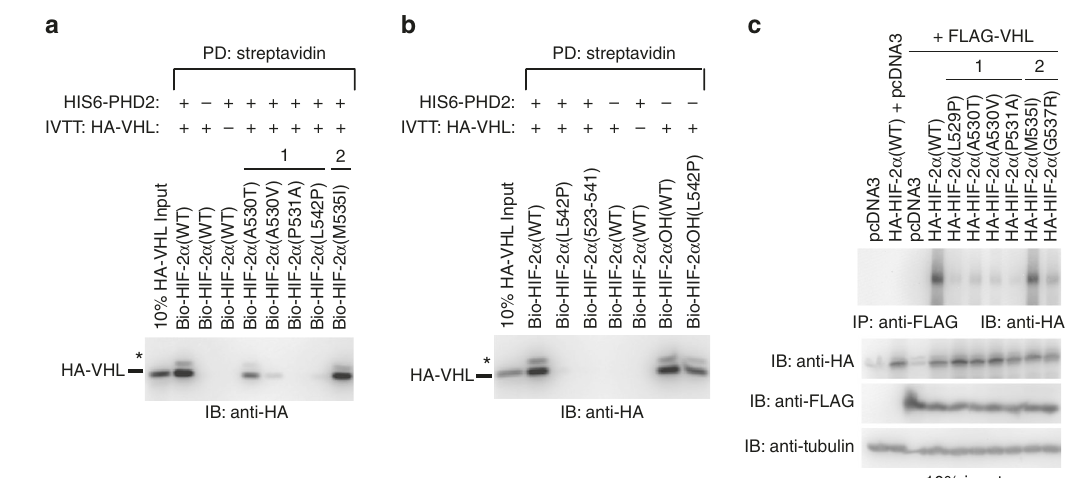
Fig. 5 A subset of class 1 mutations speci fi cally disrupts PHD2-mediated hydroxylation. a , b Biotinylated HIF-2 α peptides (residues 523 – 542) were immobilized on streptavidin- agarose beads and incubated with HIS 6 -PHD2 for 1 h at room temperature prior to incubation with in vitro transcribed and translated (IVTT) pVHL. Streptavidin beads were pulled down (PD) and levels of HA-tagged pVHL were visualized via immmunoblotting (IB). c HEK293a cells were co-transfected with FLAG-VHL and HA-HIF-2 α constructs. FLAG was immunoprecipitated (IP) and levels of HA-tagged HIF-2 α were visualized via immunoblotting (IB). * denotes uncharacterized